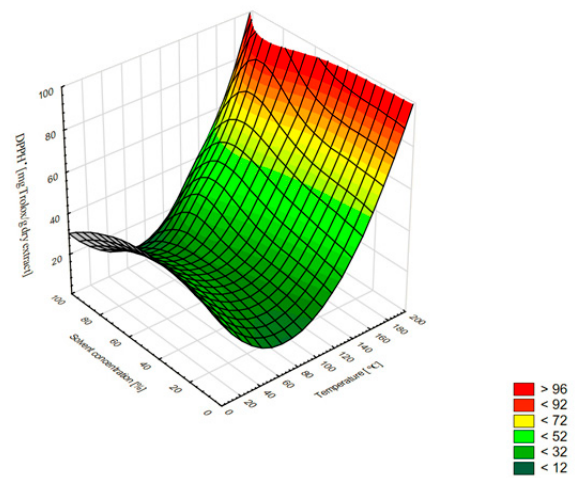
Figure 3. Three-dimensional surface chart of the DPPH • vs. temperature and solvent concentrations for all extraction methods (smoothing of the smallest squares weighted by distance).